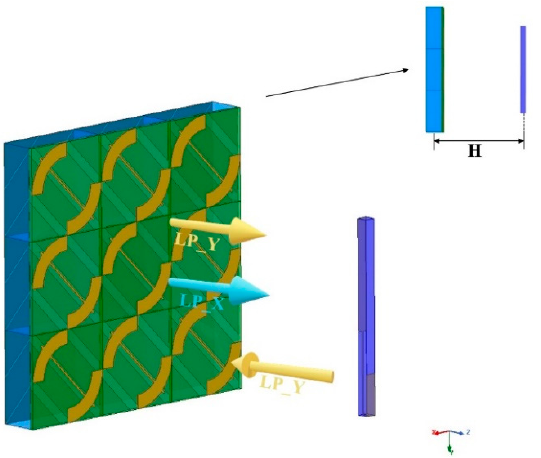
Figure 3. Polarization conversion diagram of the antenna-PCM hybrid structure.